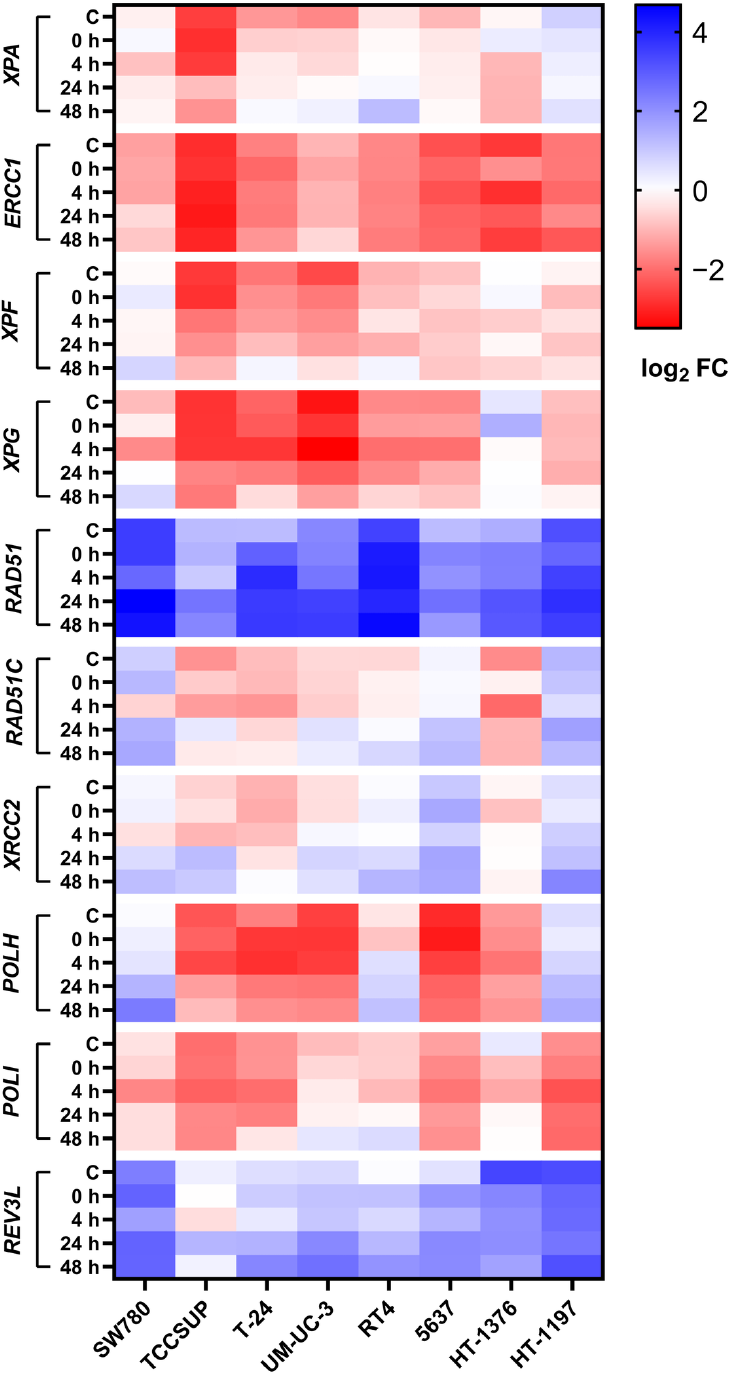
Figure 8. Changes in relative mRNA expression of the XPA , ERCC1 , XPF , XPG , RAD51 , RAD51C , XRCC2 , POLH , POLI and REV3L genes after 2 h CDDP exposure at 0, 4, 24 and 48 h. The mRNA expression values of the respective genes are listed as the mean fold change of the transcript concentration (log 2 FC) from the three biological and three technical replicates compared to BEC. Red colour indicates relative expression lower than BEC, white colour represents expression similar to BEC, and blue represents relative expression higher than BEC. C means basal expression.